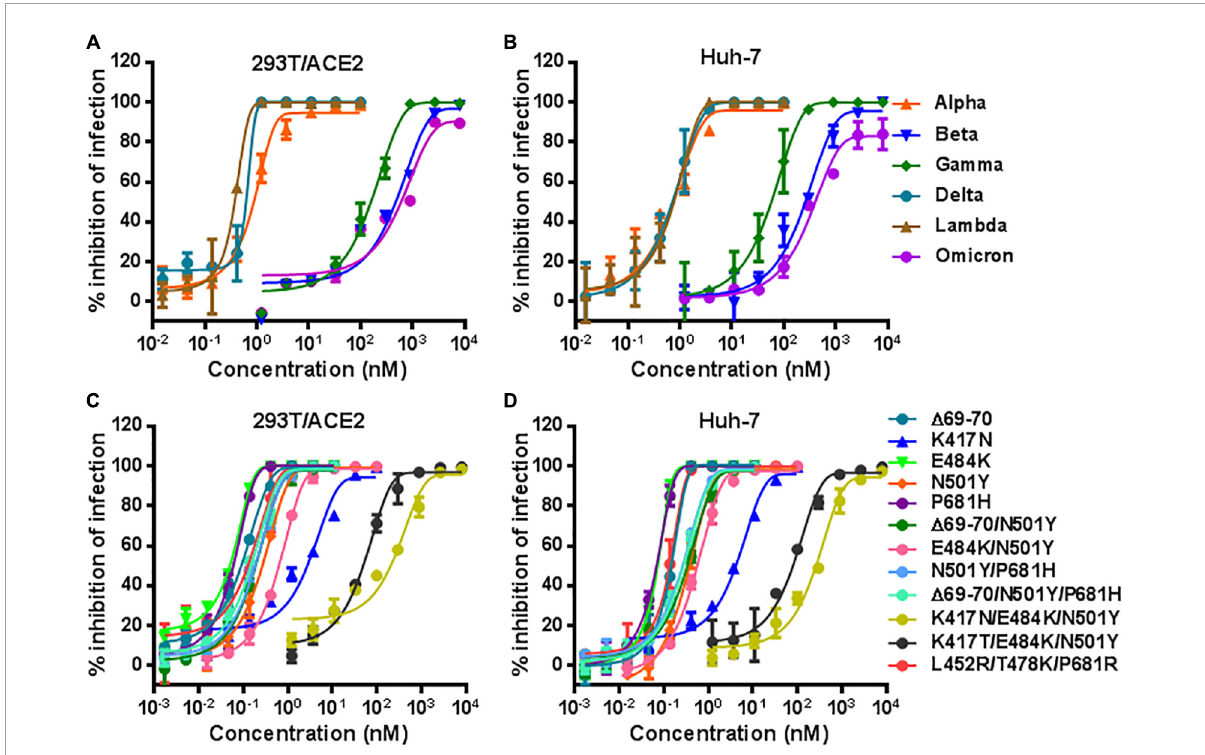
FIGURE2 Inhibitory activity of LCB1 against divergent SARS-CoV-2 variants. The activities of LCB1 peptide in inhibiting VOCs and VOI (A , B) as well as the panel of mutant pseudoviruses carrying single or combined mutations (C , D) were measured by the single-cycle infection assay. Samples were tested in triplicate, the experiments were repeated three times, and data are expressed as the means with standard deviations (SD) and presented in Table 1